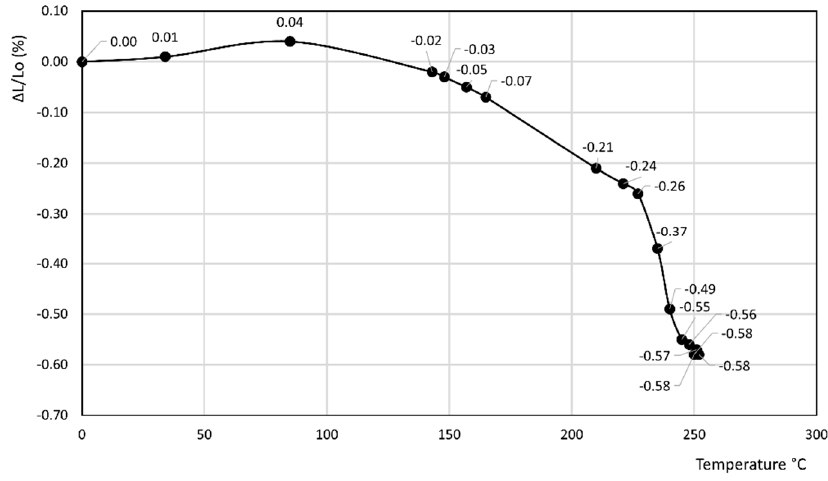
Figure 5. Thermodilatometric curve of rock 5, Neapolitan Yellow Tuff from Toledo subway sta ‐ tion.